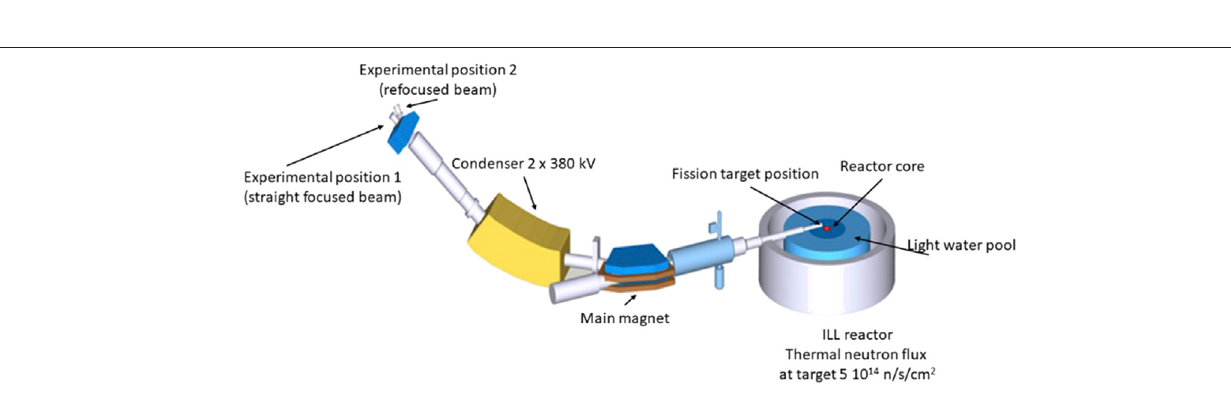
FIGURE4| eBICcartographydoneatInstitutNéelofthethreediamondsamples:detectorA (A) ,azoomona1 mm 2 areaofthedetector C (B) anddetectorF (C) .